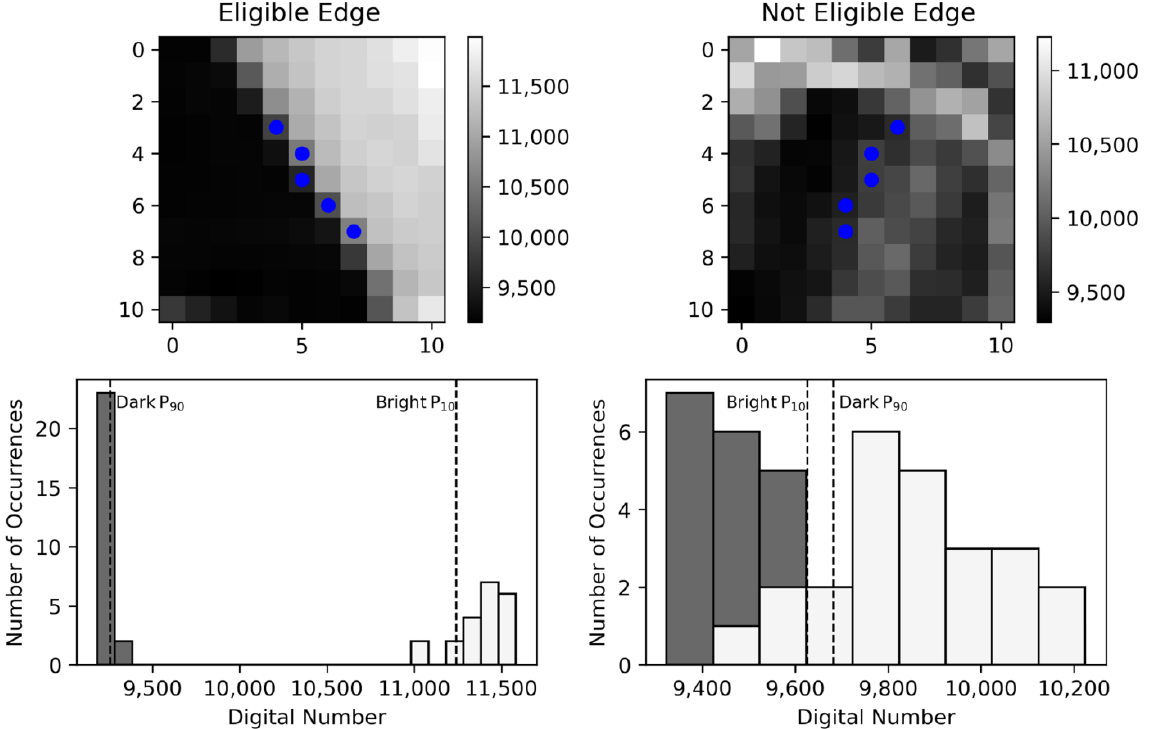
Figure 2. In the first row, the figure shows an example of an eligible edge (first column) and an example of a not eligible edge (second column) detected by the SaSbEM. The edges and the adjacent bright and dark areas are displayed in the upper part of each box. In the second row, instead, the figure shows the frequency histograms of the DN present in the dark and bright areas. The histograms of the eligible edge are displayed in the first column, the histograms of the not eligible edge are displayed in the second column. The comparison between the two frequency histograms highlights the differences between the statistical population of the corresponding bright and dark areas.